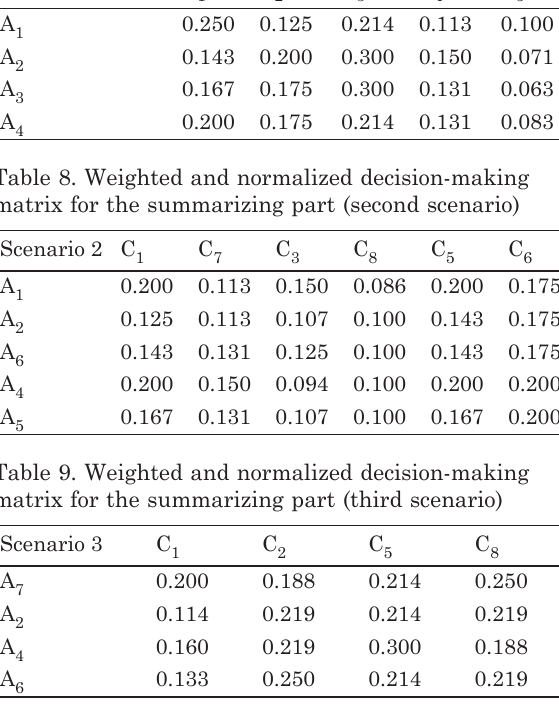
Table 7. Weighted and normalized decision-making matrix for the summarizing part (first scenario) scenario 1